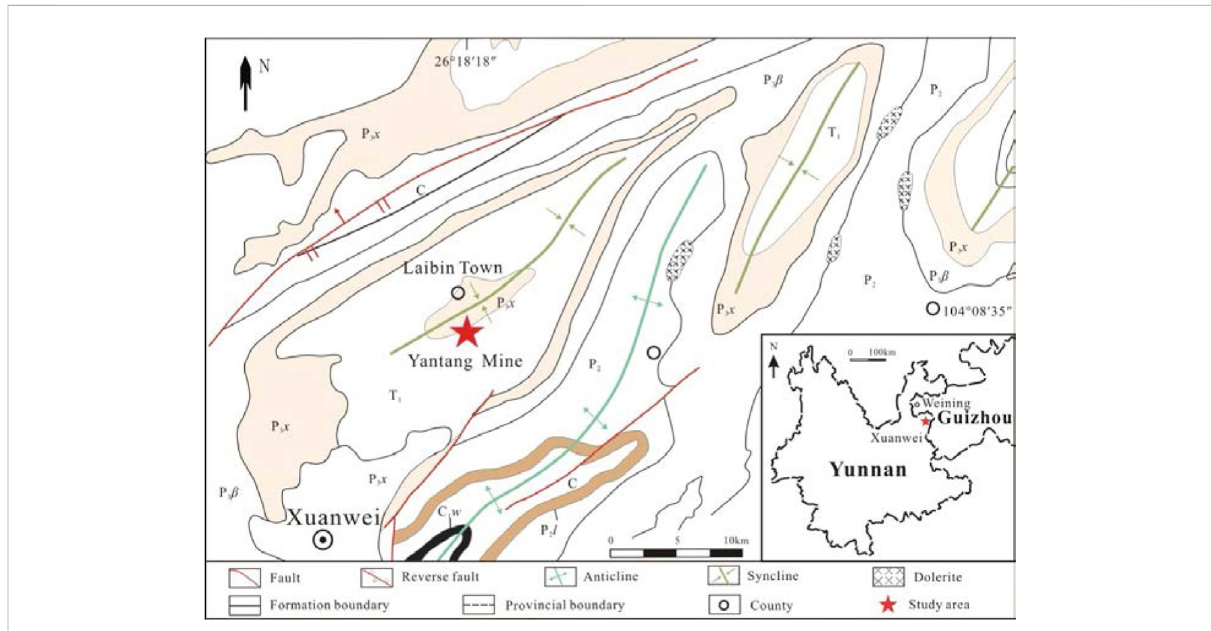
Frontiers in Earth